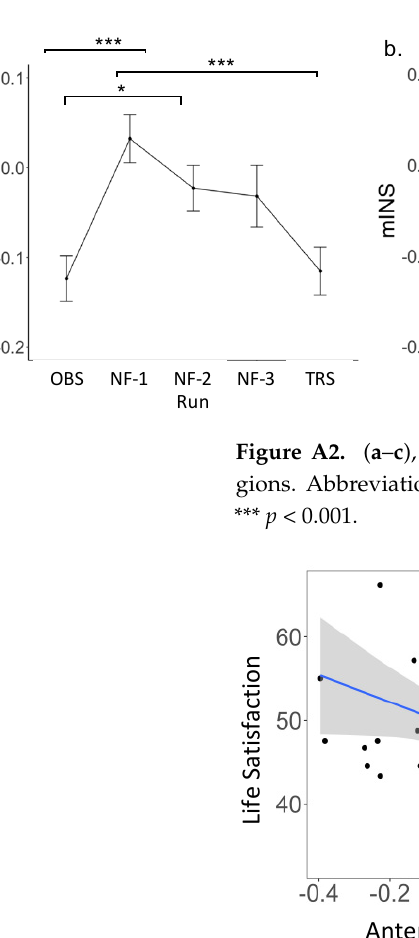
Figure A1. Barplot of the signal variance ratio (R^2 value) explained by the physiological noise re- gressors (RETROICOR) for the real-time processed and offline processed signals in the PCC region.